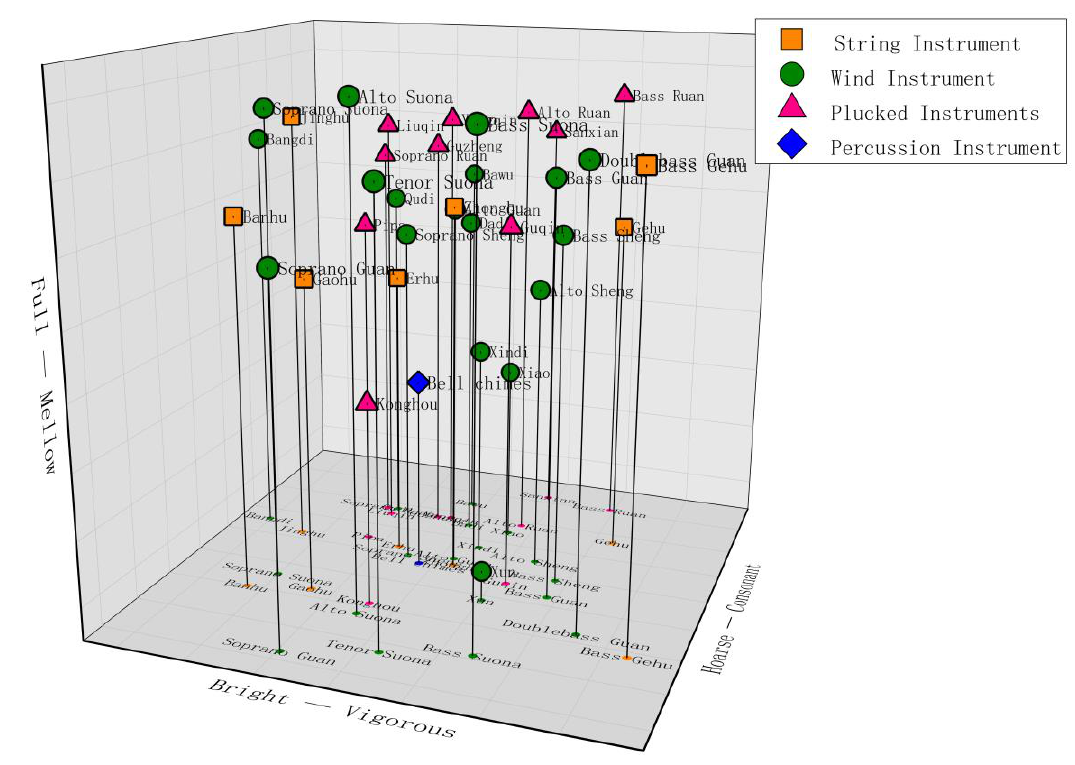
Figure 6. A 3D timbre space for 37 Chinese instruments.